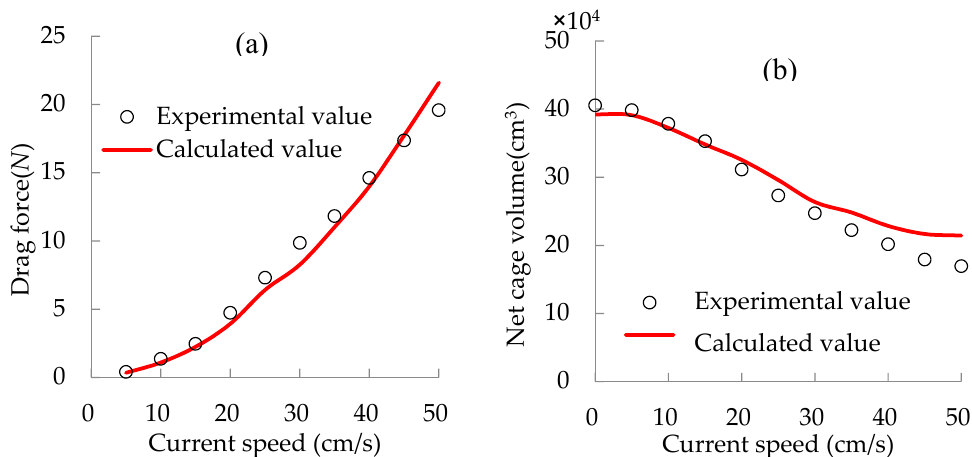
Figure 16. Comparison of drag force and cage volume between the experimental and simulation